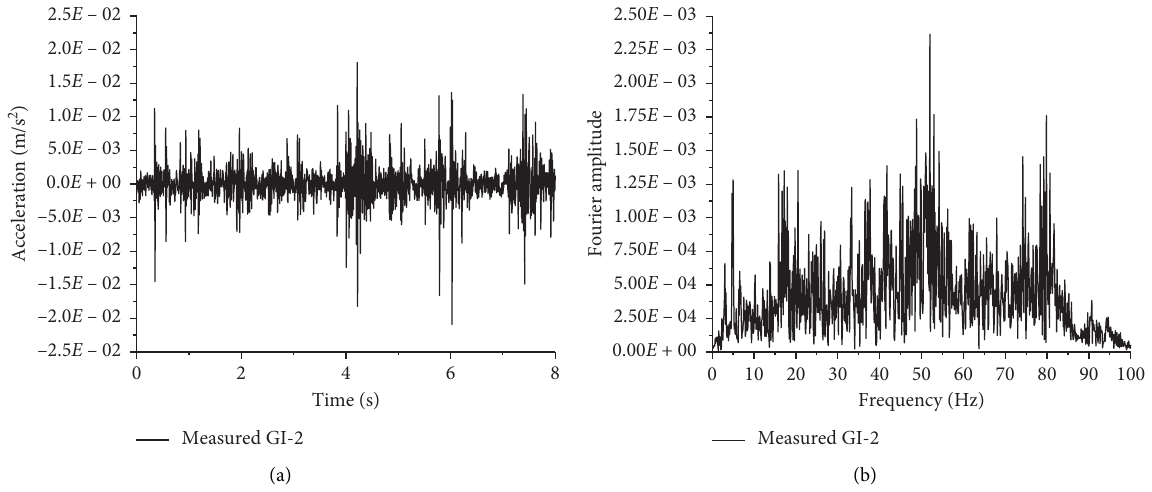
Figure 4: Acceleration: (a) time history and (b) frequency spectrum of